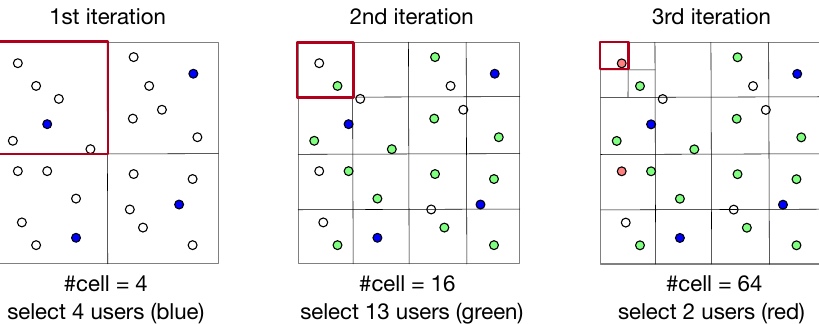
Figure 6. Example of ParRand , which terminates in its third iteration because of the budget overrun.